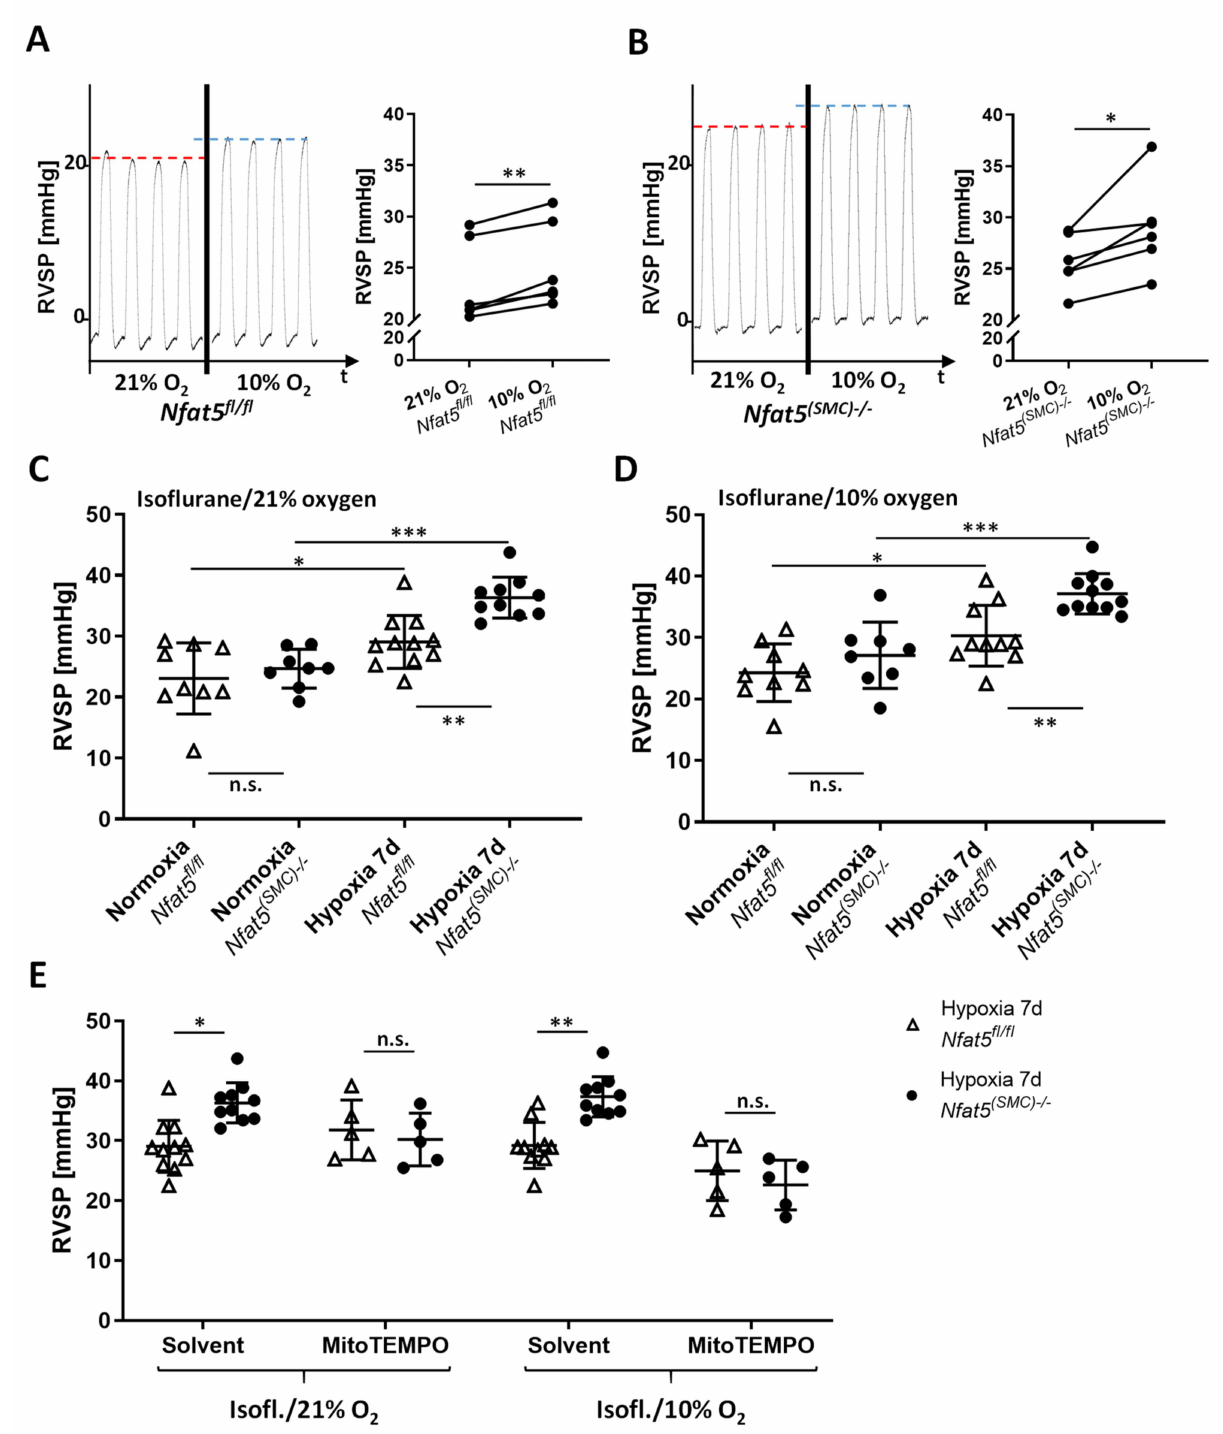
Figure 7. Right ventricular systolic pressure (RVSP) in Nfat5 fl/fl and Nfat5 (SMC) − / − mice. ( A , B ) The right ventricular systolic pressure (RVSP) was determined in anesthetized mice and was increased while decreasing the oxygen concentration of the isoflurane/oxygen mixture (recording of normoxia-exposed Nfat5 fl/fl and Nfat5 (SMC) − / − mice, respectively, * p < 0.05, ** p < 0.001 as indicated, n = 5). ( C , D ) RVSP values of normoxia/hypoxia (7 d)-exposed Nfat5 fl/fl and Nfat5 (SMC) − / − mice anesthetized with isoflurane/21% oxygen and isoflurane/10% oxygen (* p < 0.05, ** p < 0.01, *** p < 0.001 as indicated, n = 6–13). ( E ) RVSP was determined in anesthetized (isoflurane/21% or isoflurane/10% oxygen) mice after their exposure to hypoxia for 7 d right after treatment with the mitochondrial ROS scavenger MitoTEMPO (* p < 0.05, ** p < 0.01, not significant (n.s.) as indicated, n =